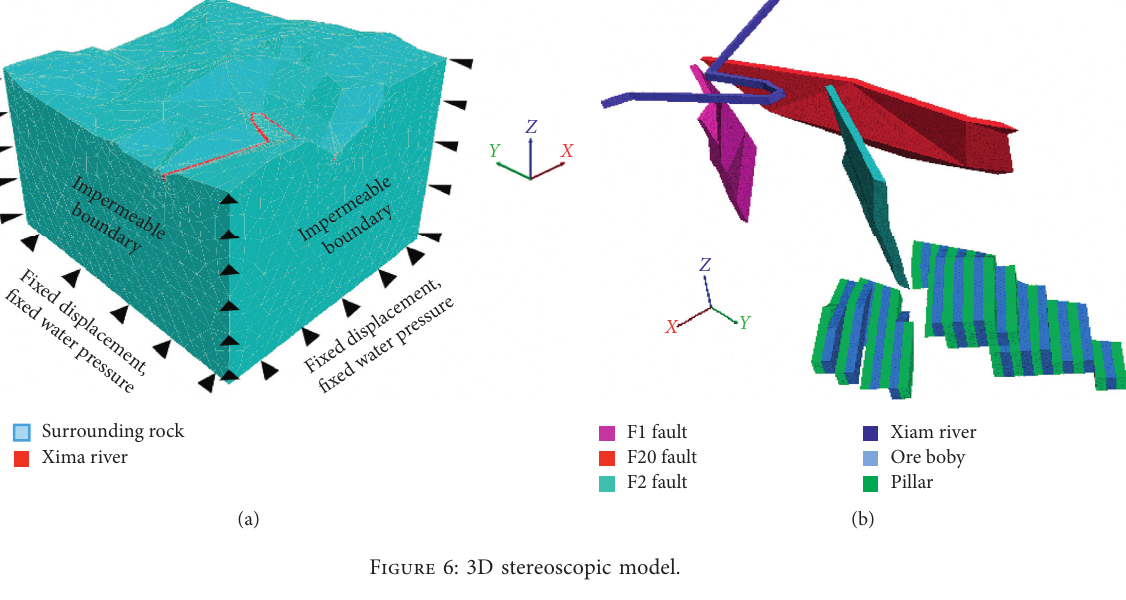
Figure 6: 3D stereoscopic model.